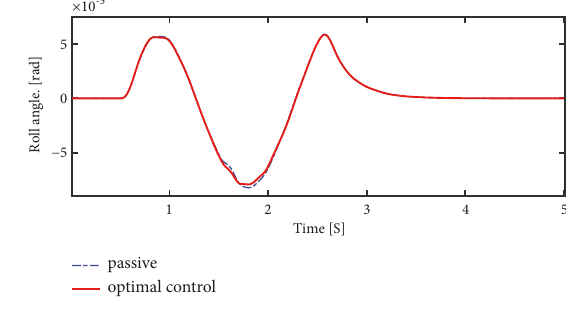
Figure 24: Time history response of roll angle.